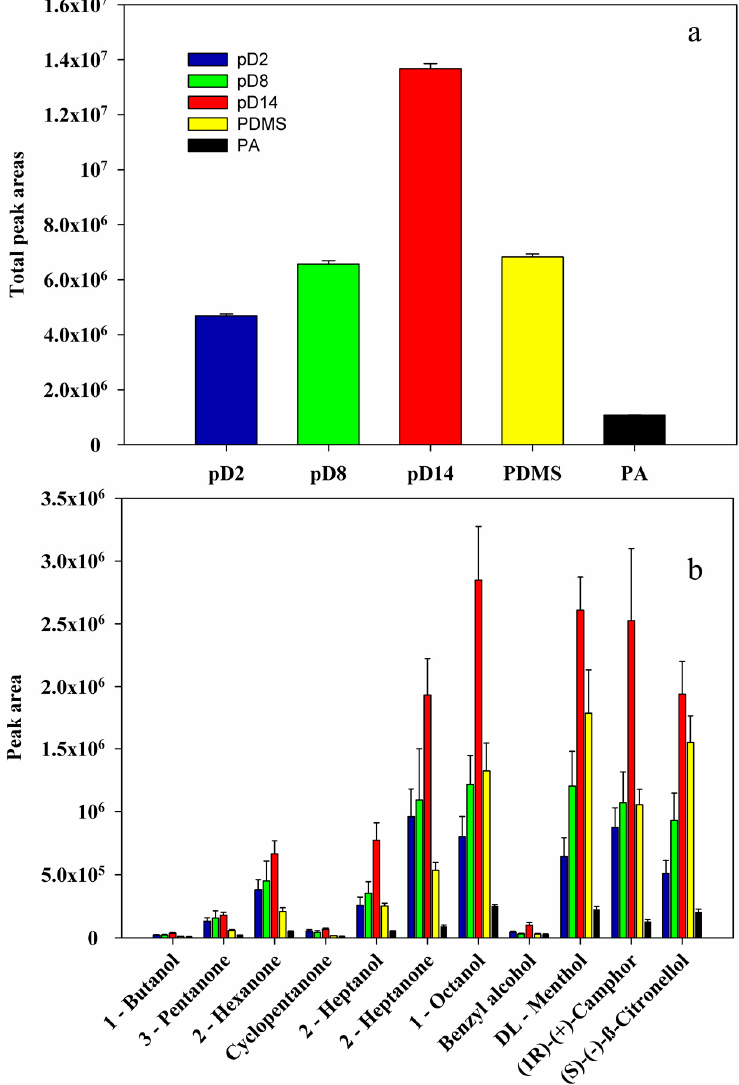
Figure 6. Comparison and performance of the prepared fibers along with commercial fibers in terms of: ( a ) total detected areas and ( b ) individual compound area. ( T = 45 °C, t = 15 min, 2.5 wt % of NaCl, 200 rpm, concentration: 200 mg·L − 1 ).